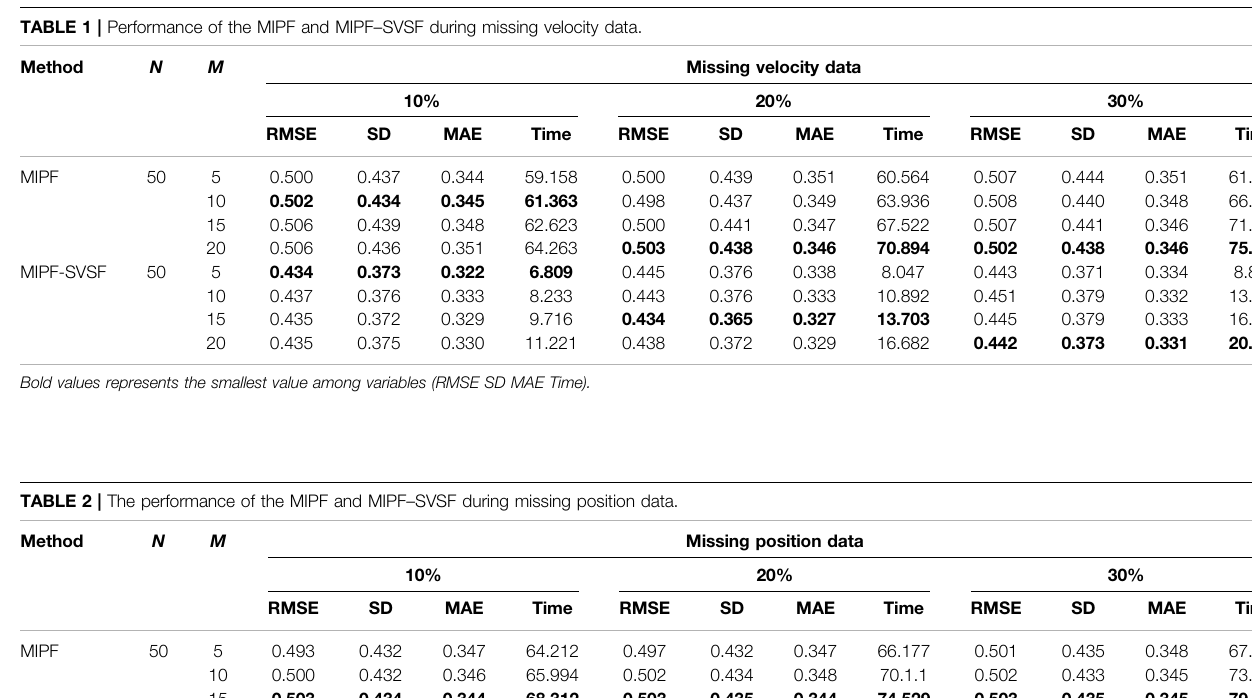
TABLE 1 | Performance of the MIPF and MIPF – SVSF during missing velocity data. Method